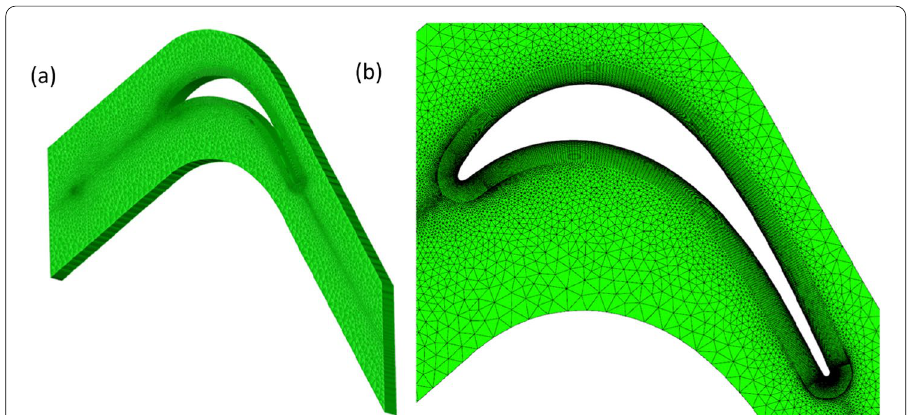
Fig. 2 Mesh of disturbed case II: ( a ) macroscopic finite element grid distribution of computational domain and ( b ) zoomed in grid near the blade